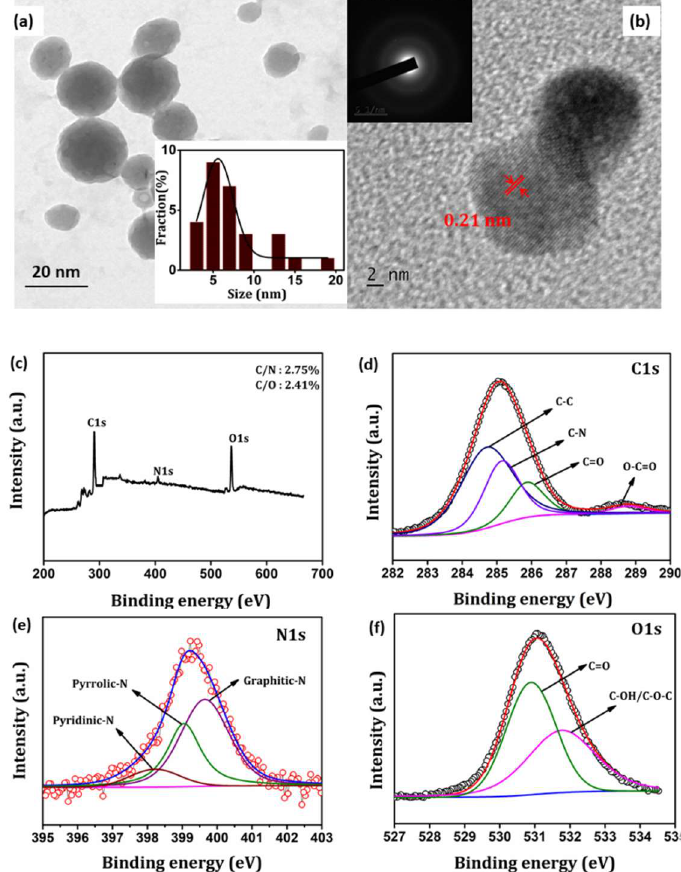
Figure 1. ( a ) TEM images of N-GQDs, ( b ) HR-TEM image of N-GQDs. ( c ) The XPS survey scan of N-GQD. ( d – f ) Core-level spectra XPS spectra of the C 1s, N 1s, and O 1s of N-GQD, respectively. The insets a and b show the particle size distribution and the SAED pattern of N-GQDs, respectively. Figure 2a shows the FTIR spectra of N-GQD and PIN in the range of 4000–400 cm −1 .